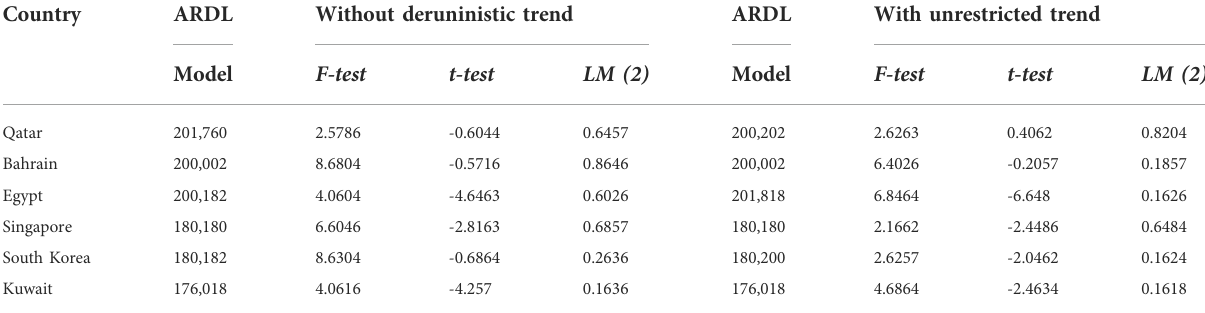
TABLE 10 Bound testing results for the growth